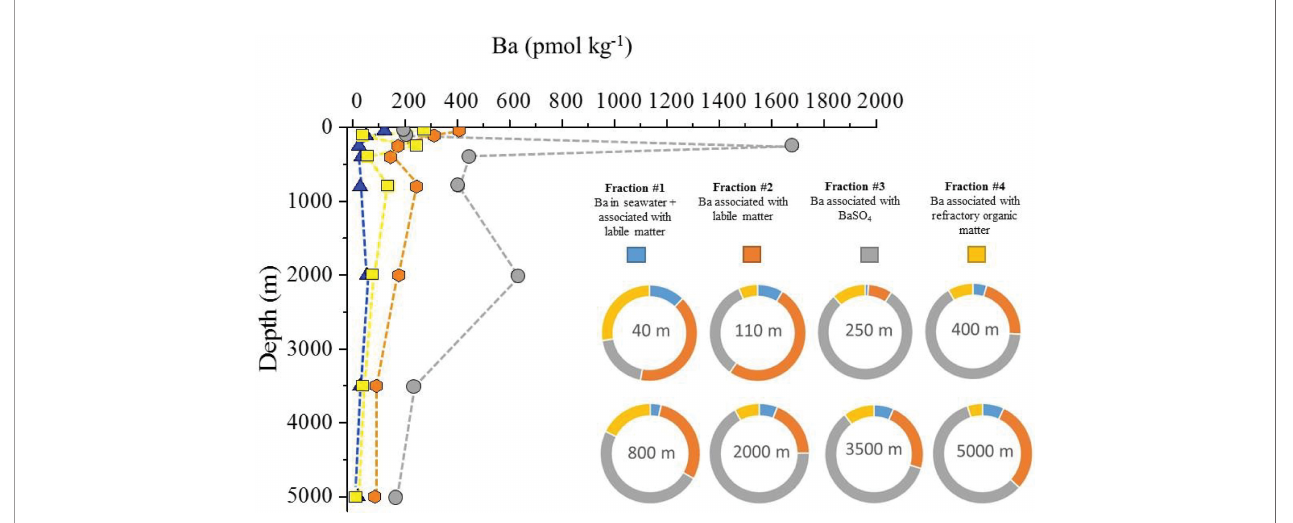
FIGURE 7 | Vertical pro fi les of Ba concentrations determined in the different particulate fractions collected using the sequential leaching method of Ganeshram et al. (2003) at station K3. The relative importance of the different fractions is also shown at each